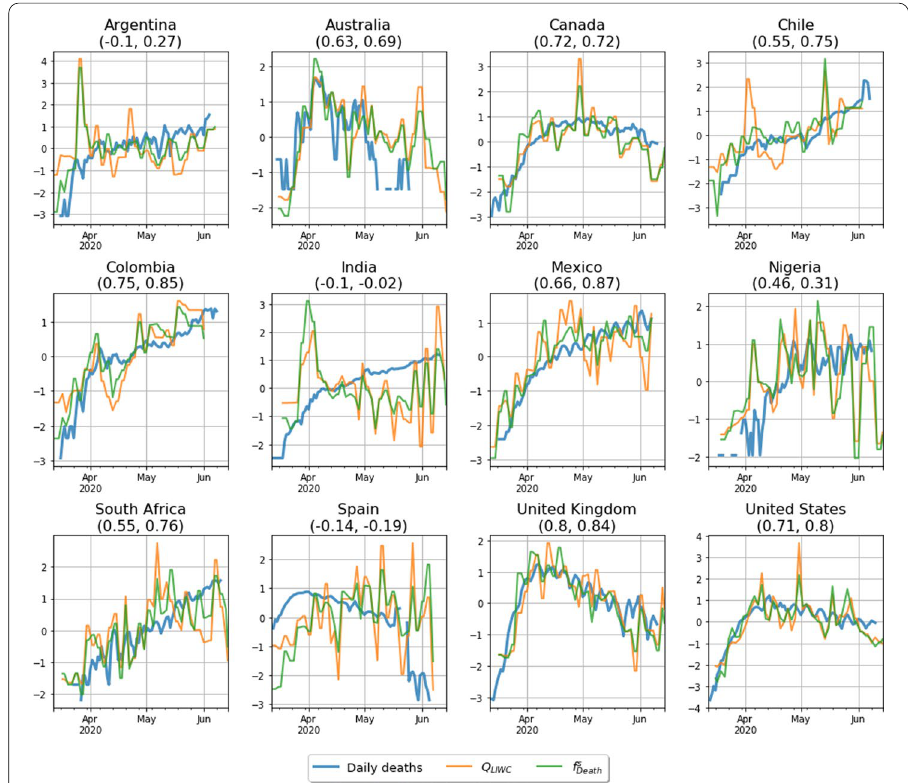
Fig. 4 Panel plot time series for the network measures Q LIWC (orange) and f Death (green) [see Eqs. (6) and (7) respectively], and the log of the national daily deaths (blue). Each panel represents a country, and in parentheses we show the Pearson correlation coefficients between these network measures and the log of the national daily deaths. Data is smoothed with a 3-day moving average and standardised by their z